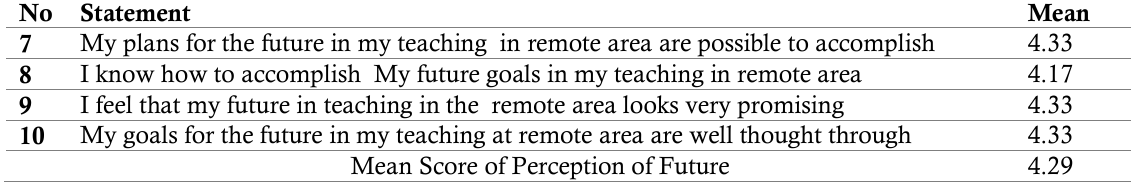
Table 2 . Personal Strength/Perception of Future